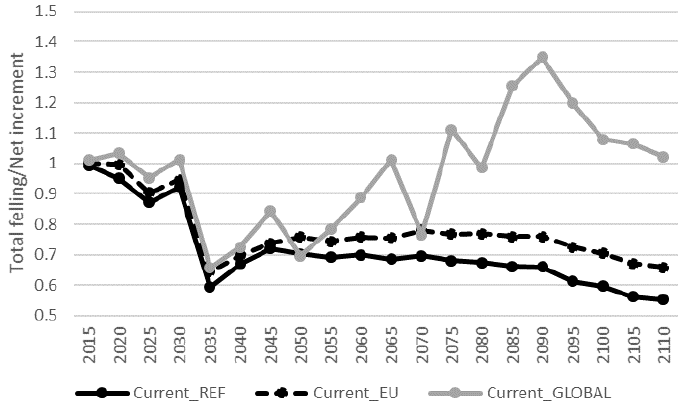
Figure 4. Projected harvests (expressed as percentage of first period harvest) of roundwood (sawlogs and pulpwood from thinning and final felling) with current forest management practices in the three climate change mitigation scenarios.